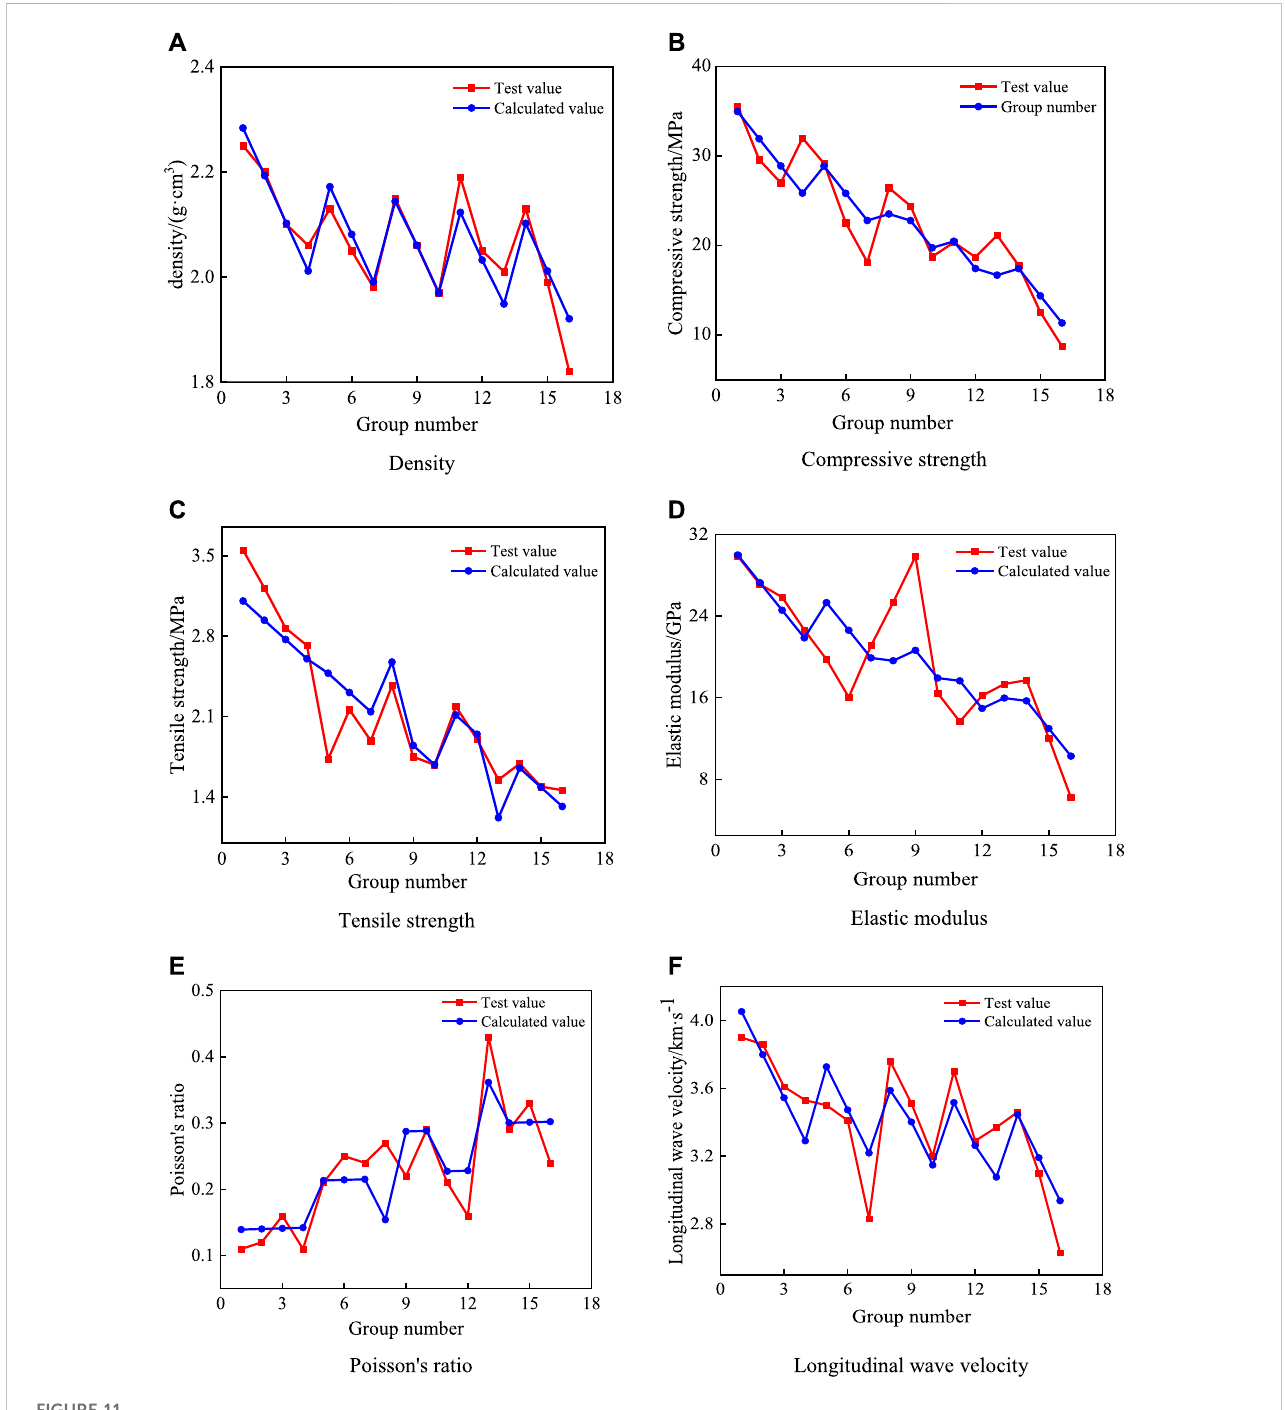
FIGURE 11 Comparison between test results and calculation results of various parameters. (A) Density (B) Compressive strength (C) Tensile strength (D) Elastic modulus (E) Poisson's ratio (F) Longitudinal wave